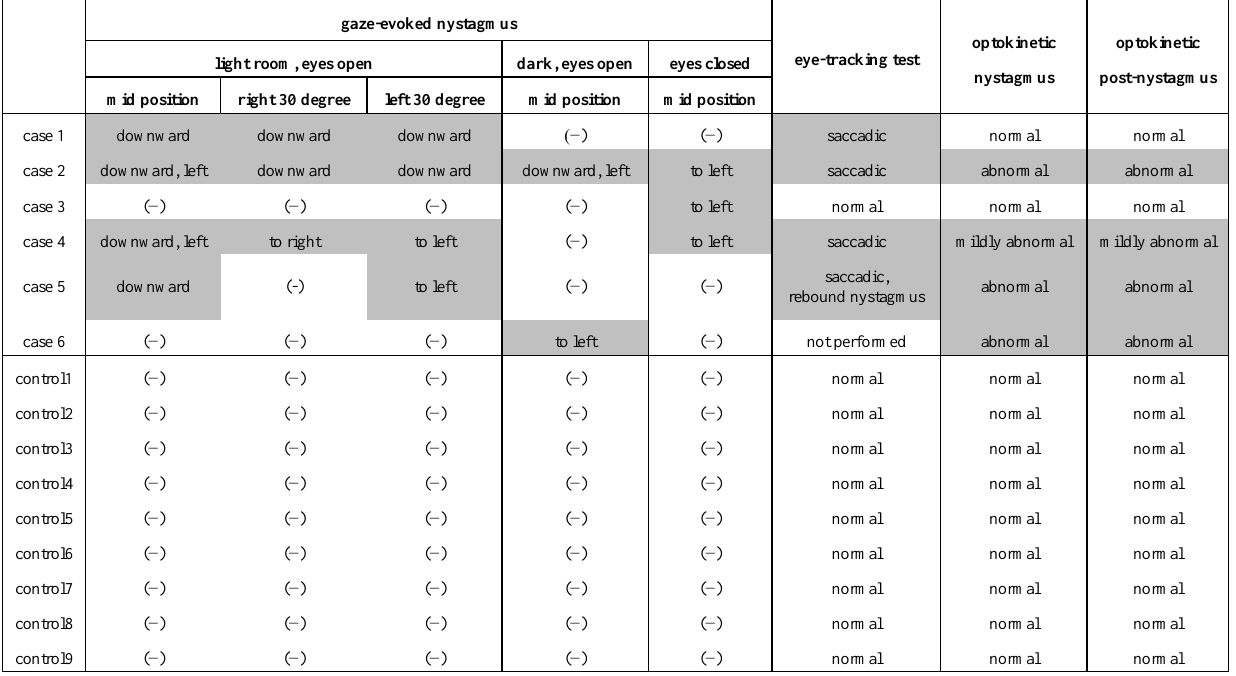
Table 1. Extra-ocular movement examination in patients with spinocerebellar ataxia type 6 (SCA6) and paroxysmal positional vertigo (BPPV) (control).